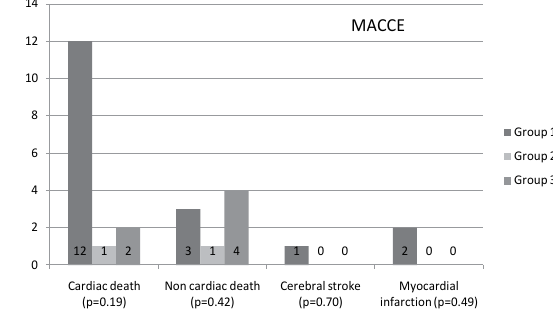
Figure 3. Occurrence of Major Adverse Cardiac and Cerebrovascular Event (MACCE)